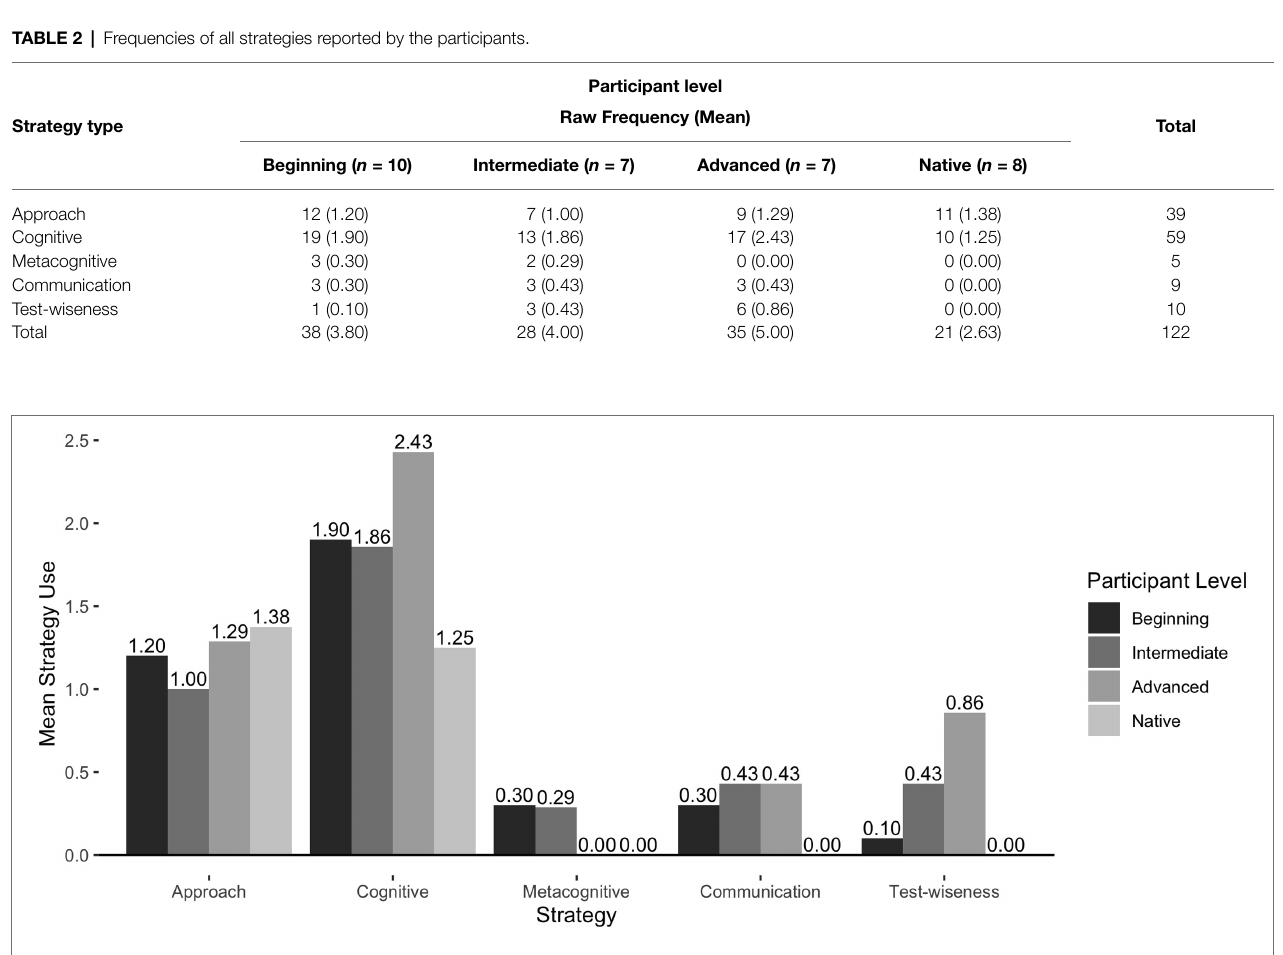
FIGURE 1 | Mean frequencies of strategy use by participant